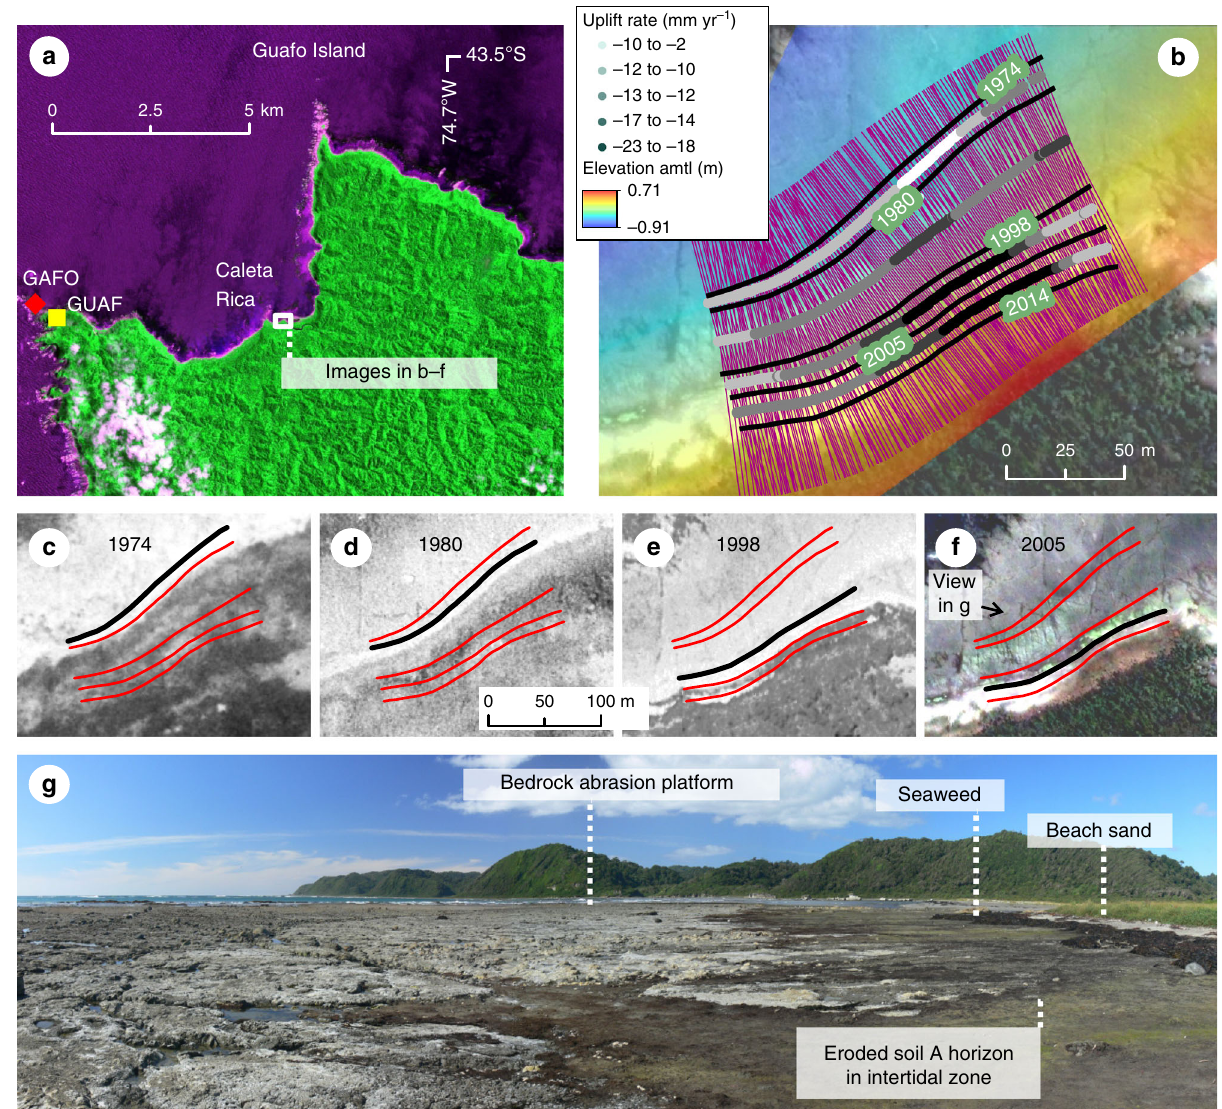
Fig. 2 Modern relative sea-level (RSL) rise at Guafo. a SPOT satellite image showing location of Caleta Rica site and permanent GPS station GUAF and campaign site GAFO. b RSL rise estimated using progressive retreat of the boundary between beach sediment and bedrock abrasion platform (using aerial images in c ) and 0.5-m-scale topography (Methods, Supplementary Table 1, Supplementary Figs. 7-9). Gray-coded stripes show local rate estimated from each adjacent shoreline (labeled with the year) along shore-normal pro fi les (purple lines). Resulting time series in Fig. 5a and Supplementary Fig. 9. amtl- above mean tide level. Quickbird satellite image in the background. c – f Co-registered aerial imagery used to map changing position of shoreline. Image sources and details in Supplementary Table 1. Thick black line denotes mapped shoreline in the corresponding image; red lines denote shorelines on the other images (see Supplementary Fig. 7 for larger versions). g View of abrasion platform on which post-1960 peaty meadow soil developed. Location in f